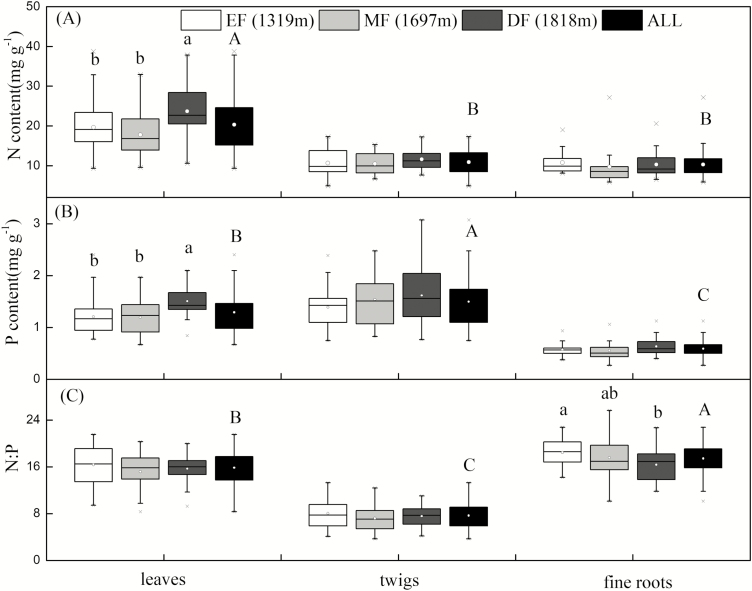
Comparisons of (A) nitrogen (N) content, (B) phosphorus (P) content and (C) the N:P ratio of leaves, twigs and fine roots in an evergreen broad-leaved forest (EF), a coniferous and broad-leaved mixed forest (MF), a deciduous forest (DF) and all elevations (ALL). The distribution of N, P and N:P for different plant organs is characterized by the box plots, where the box length provides the interquartile range, the bottom and the top of the box represent the 25th and 75th percentile, respectively, the horizontal line within the box represents the median value, and the circle within the box represents the mean value. The crosses denote values outside the whisker limit. Different lower- and upper-case letters above the columns indicate significant differences (P < 0.05) between elevations and organs, respectively.